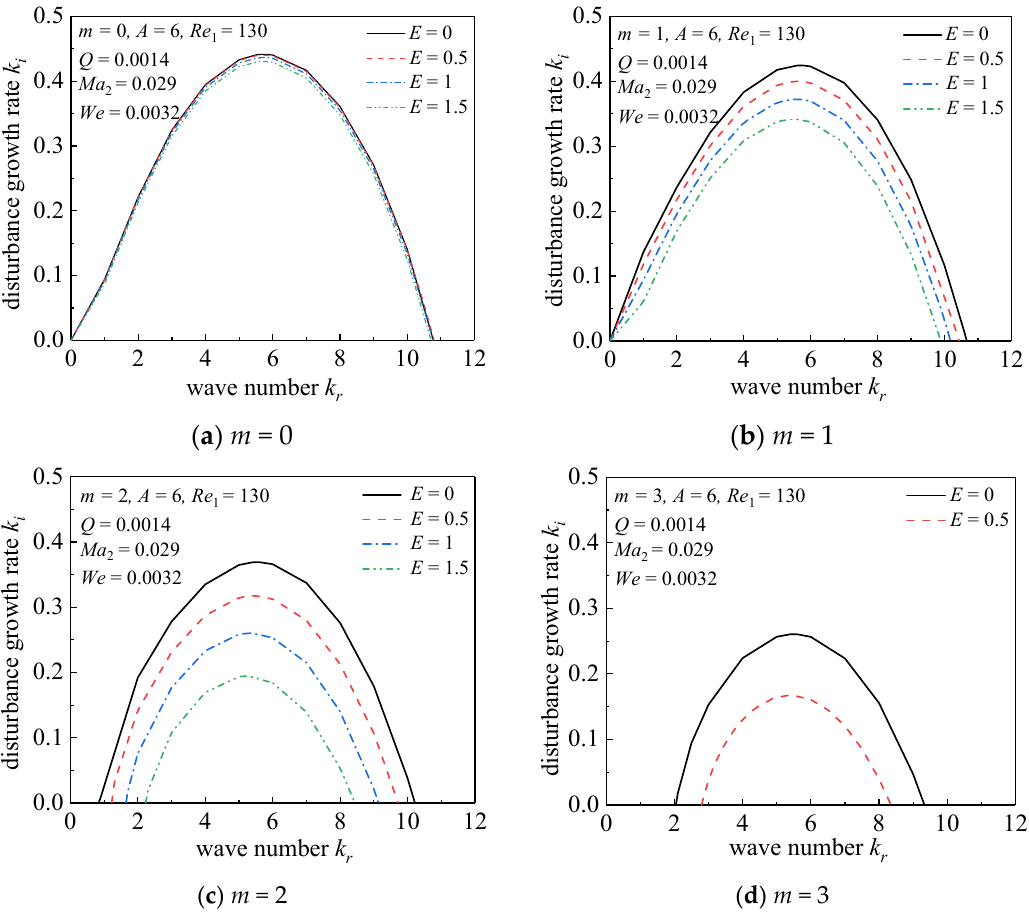
Figure 7. Effects of twisting airflow on jet stability under the axisymmetric and asymmetry mode.